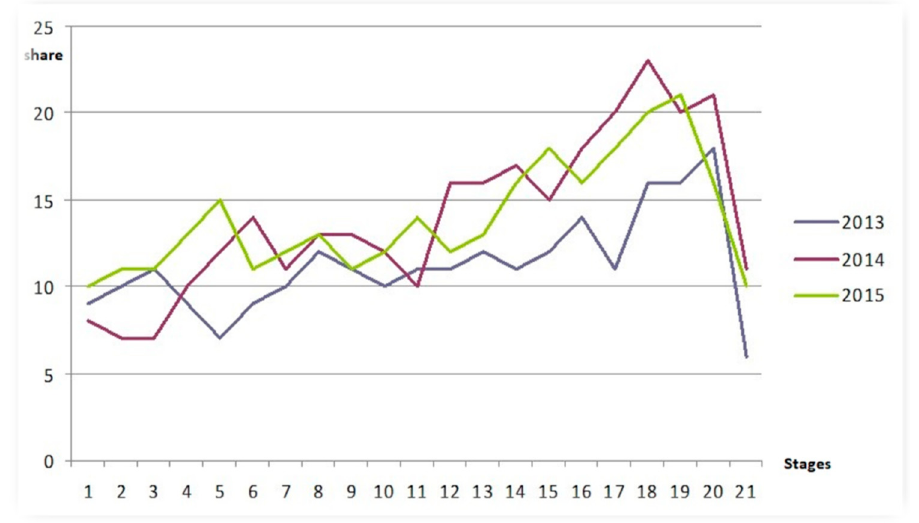
Figure 7. TV Auditel share/stages of the Giro.